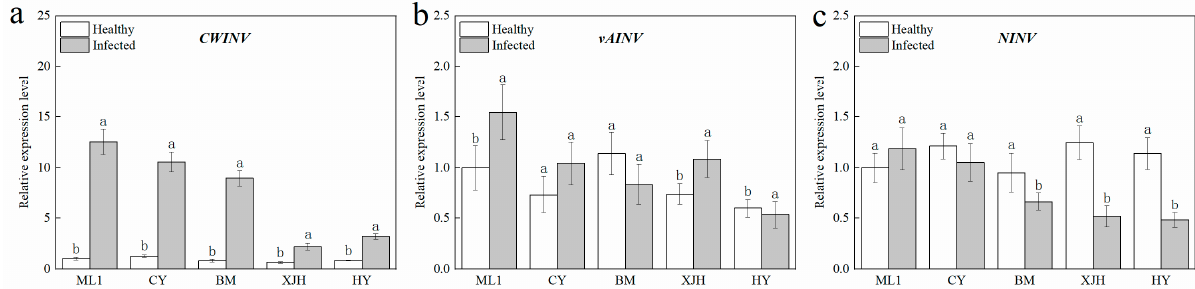
Figure 4. The relative expression level of CWINV ( a ), vAINV ( b ), and NINV ( c ) in the phloem of five kiwifruit cultivars canes after 30 days inoculation of Pseudomonas syringae pv. actinidiae (Psa). The data represent means from three biological replicates. Error bars = SD. Columns with different letters are significantly different at p < 0.05.